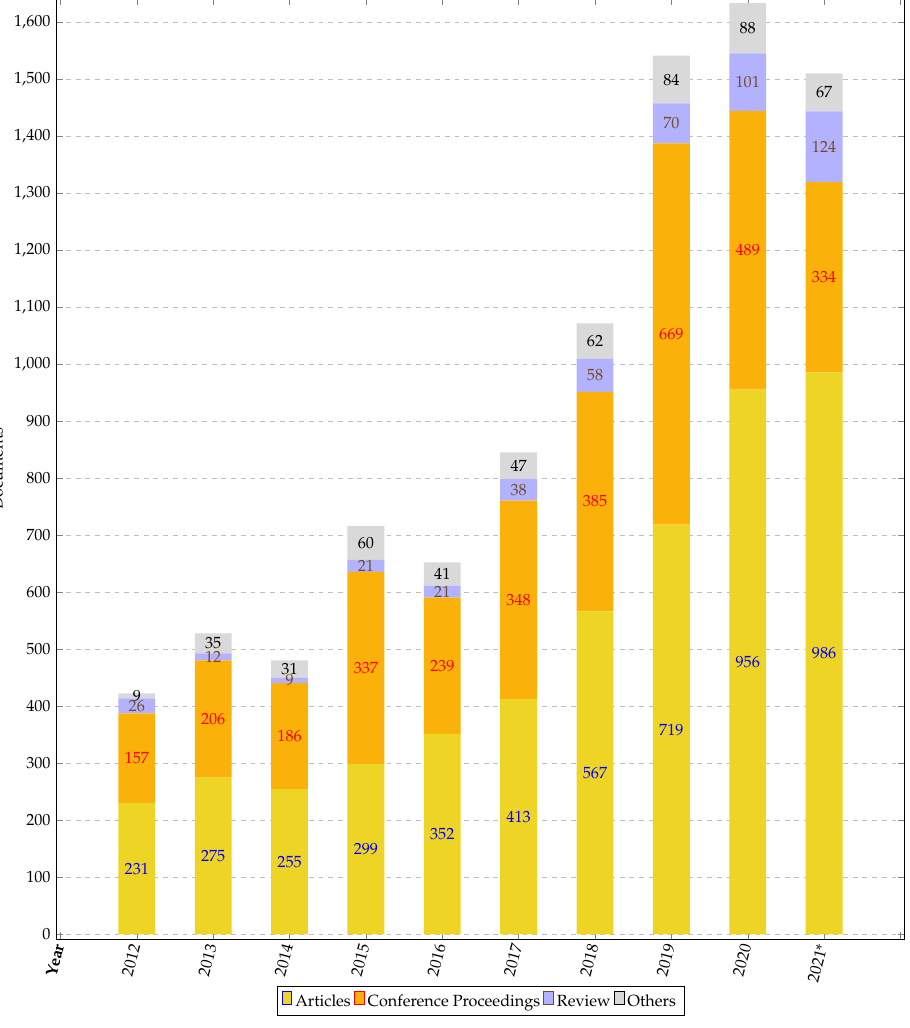
Figure 1. Documents published in precision agriculture in the last 10 years (* prior to 15 November